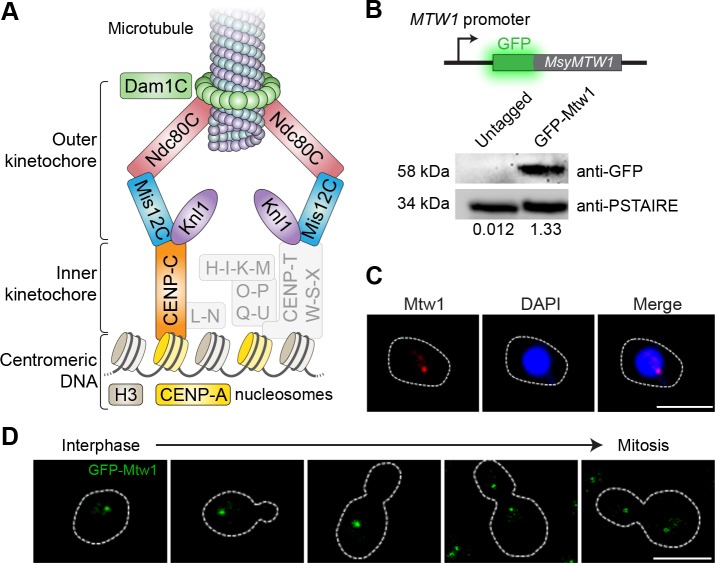
Kinetochores cluster and localize at the nuclear periphery in M. sympodialis.(A) Schematic of the kinetochore organization of M. sympodialis. Gray boxes indicate proteins absent in M. sympodialis. The outer kinetochore protein Mtw1 (a component of Mis12C) served as the kinetochore marker in the present study. (B) Line diagram representation of Mtw1 tagged with GFP at the N- terminus. Immunoblot analysis of whole-cell lysates prepared from the untagged M. sympodialis strain (ATCC42132) and from GFP-Mtw1 expressing cells (MSY001) probed with anti-GFP antibodies and anti-PSTAIRE antibodies. PSTAIRE served as a loading control. Relative intensity values normalized to PSTAIRE are indicated below each lane. (C) Logarithmically grown MSY001 cells expressing GFP-Mtw1 were fixed and stained with DAPI (blue) and anti-GFP antibodies (pseudo-colored in red). Scale bar, 2.5 µm. (D) Cell cycle stage-specific localization dynamics of GFP-Mtw1. Scale bar, 2.5 µm.